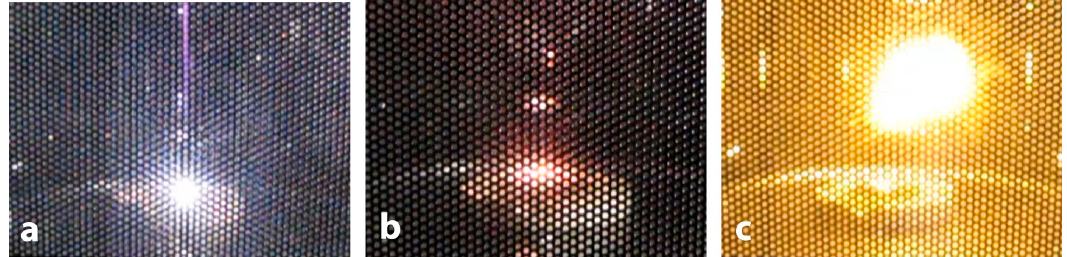
Figure 2. Examples of microwave process types. Type 2: a single spark discharge of Ag powder ( a ); type 3: red heat of W-C powder ( b ); type 4: glow of plasma observed for Mo-Fe-C powder ( c ).